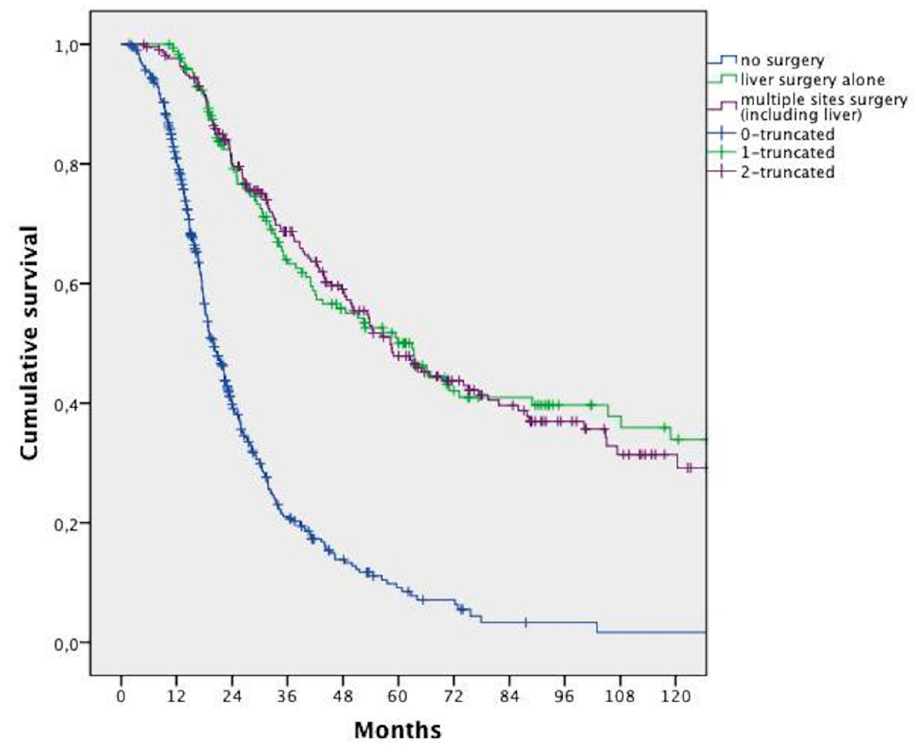
Figure 2. Overall survival analysis of patients who underwent liver surgery vs. surgery of multiple sites (including liver) vs. no surgery.